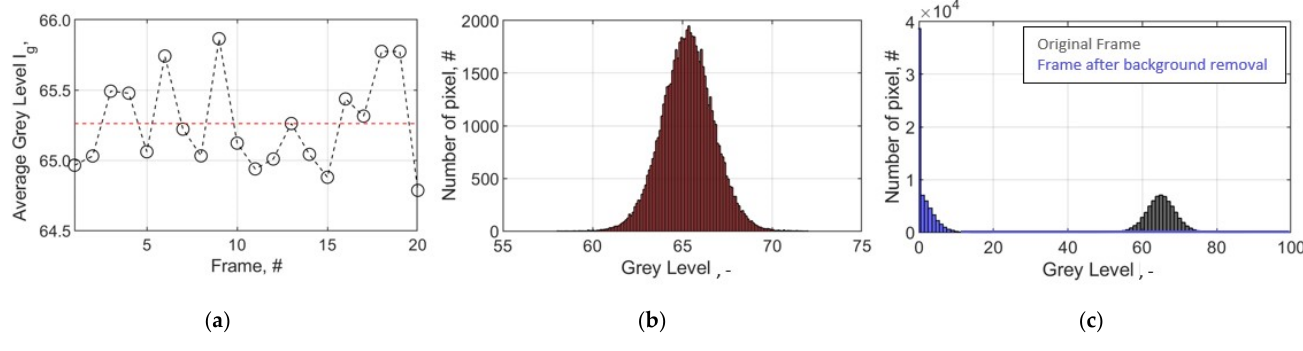
Figure 5. ( a ) Average grey level for each of the first 20 frame (black markers) and corresponding mean value of them (red dashed line). ( b ) Grey level distribution of the average noise frame. ( c ) Example of an original frame before (grey bars) and after (blue bars) the noise removing.